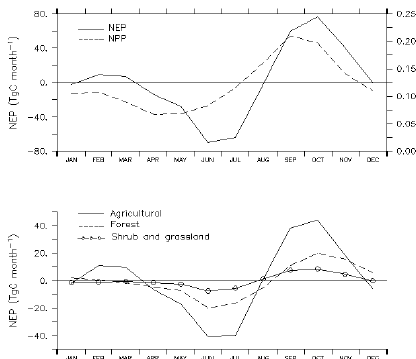
Figure 6 Monthly variation of total NEP and NPP over the country during a climatological year 1981-2006 (upper panel) and monthly variation of total NEP over different dominant land covers of the country during the climatological year.